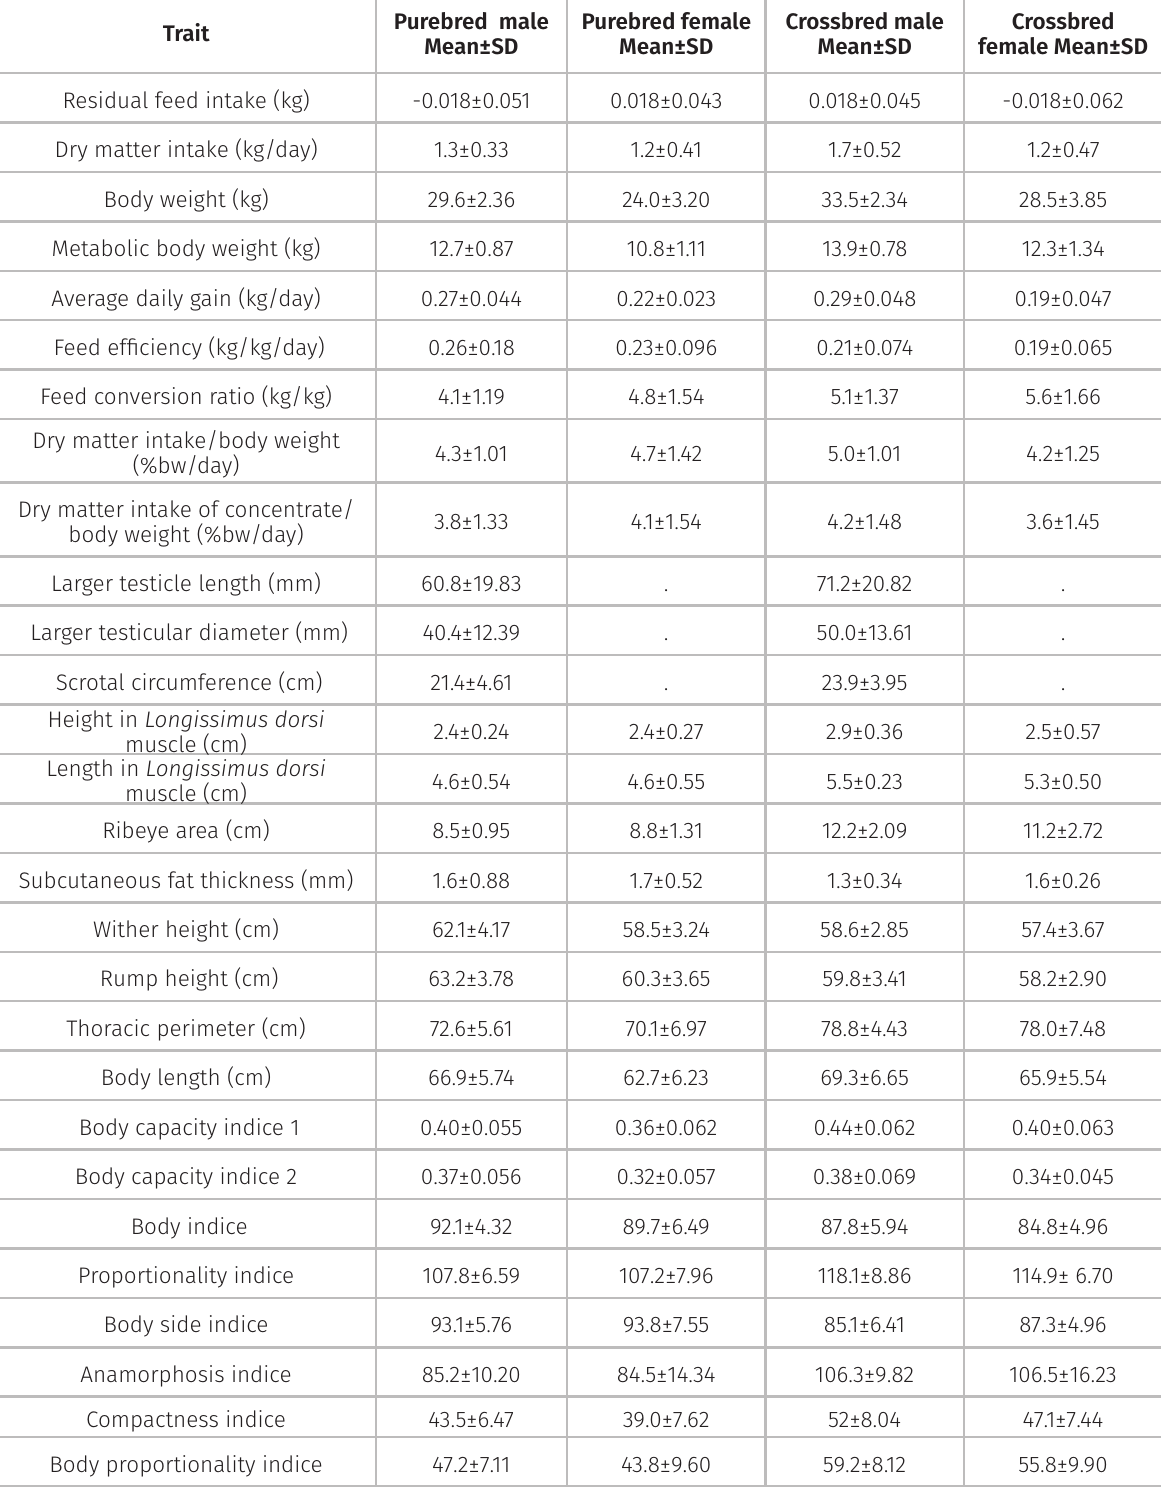
Table III. Mean and standard deviation of genetic group and sex for efficiency traits, testicular parameters, carcass ultrasound, body morphometric and indices